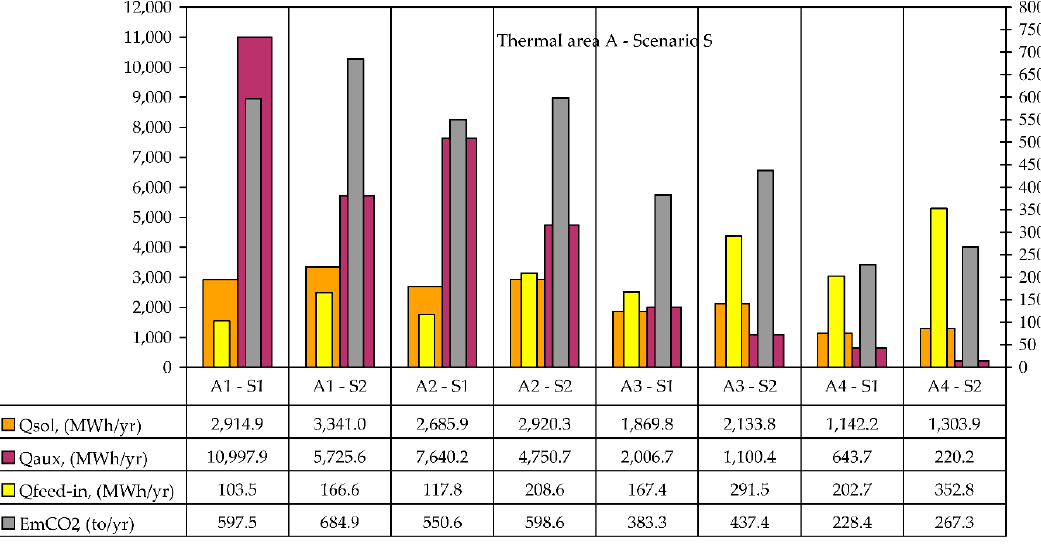
Figure 8. Areas A 1 –A 4 . Balance components. Table 10. Areas A 1 –A 4 . Indicators of thermo-energy performance.